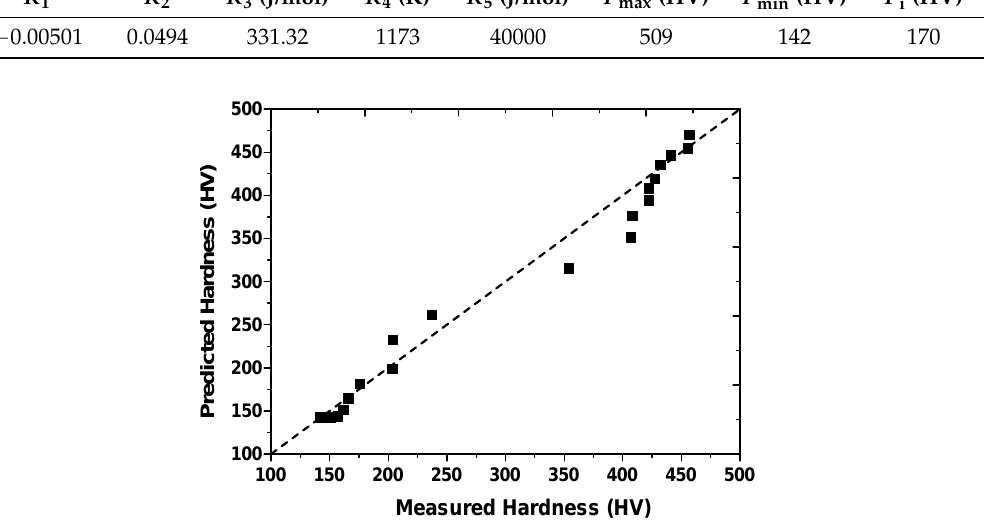
Figure 4. Comparison of hardness between measurement and prediction on the dilatometer test.